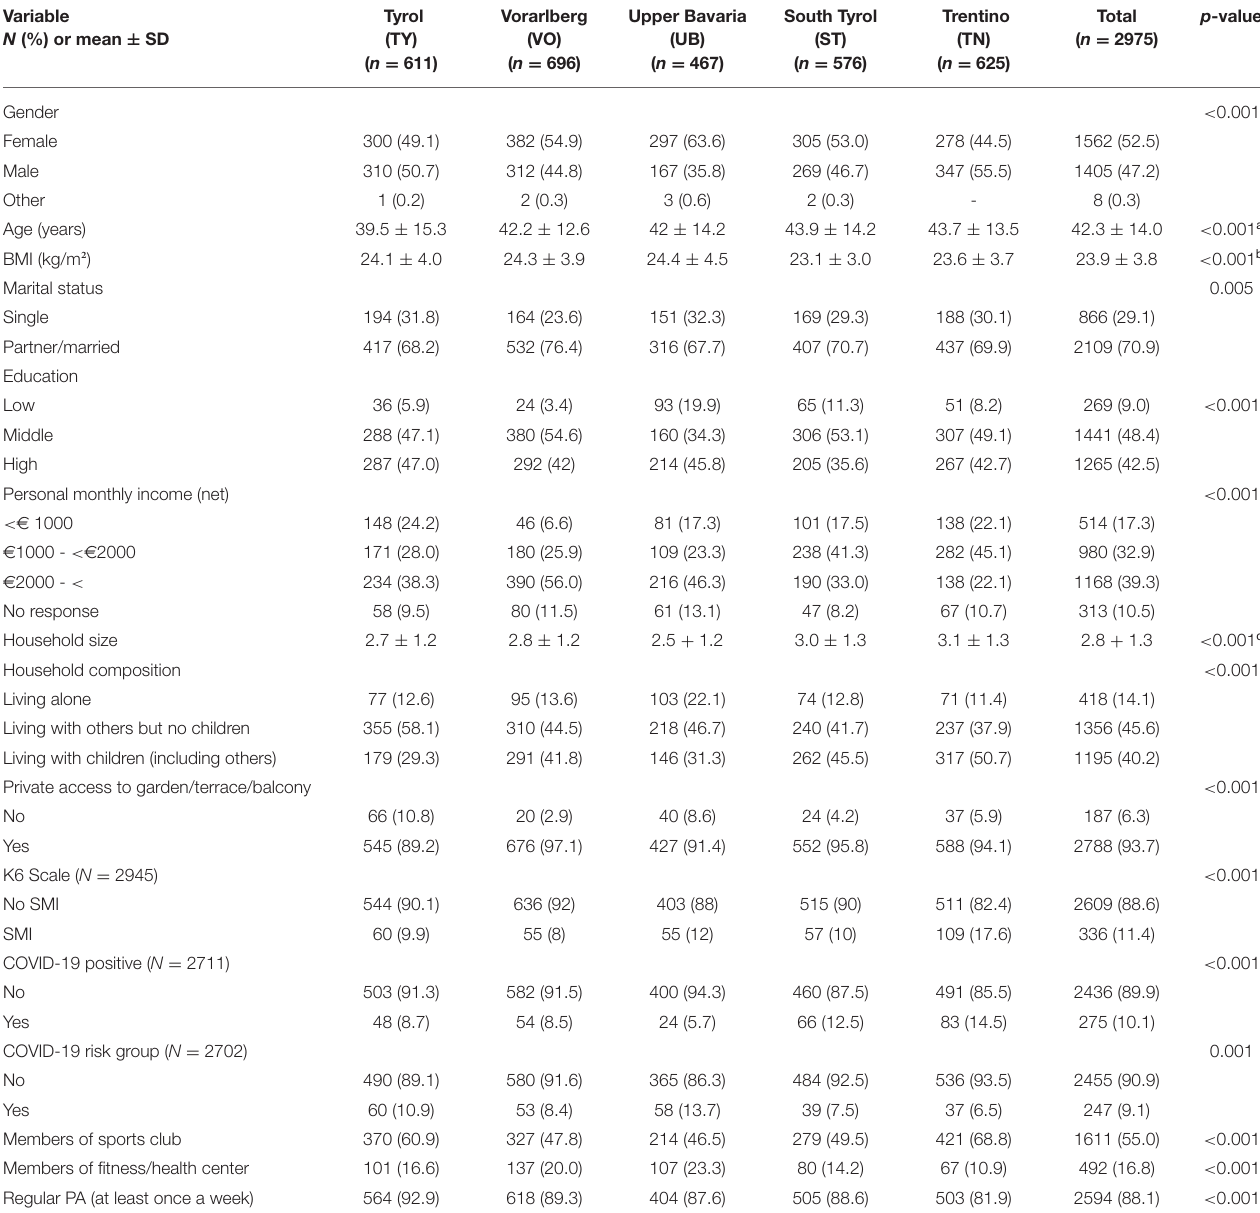
TABLE 2 | Demographic and PA-related characteristics of participants of five Alpine regions. Variable N (%) or mean ±